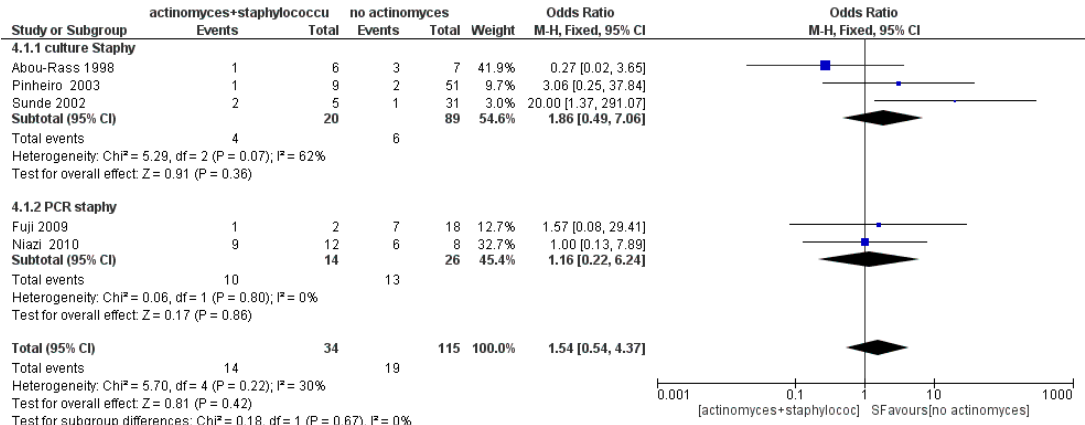
Figure 11. Forest plot of the fixed effects model of the meta-analysis of the sub-group Staphylococci. Sub-group culture (OR = 1.86, 95% CI: [0.49, 7.06]), sub-group PCR (OR = 1.16, 95% CI: [0.22, 6.24]).